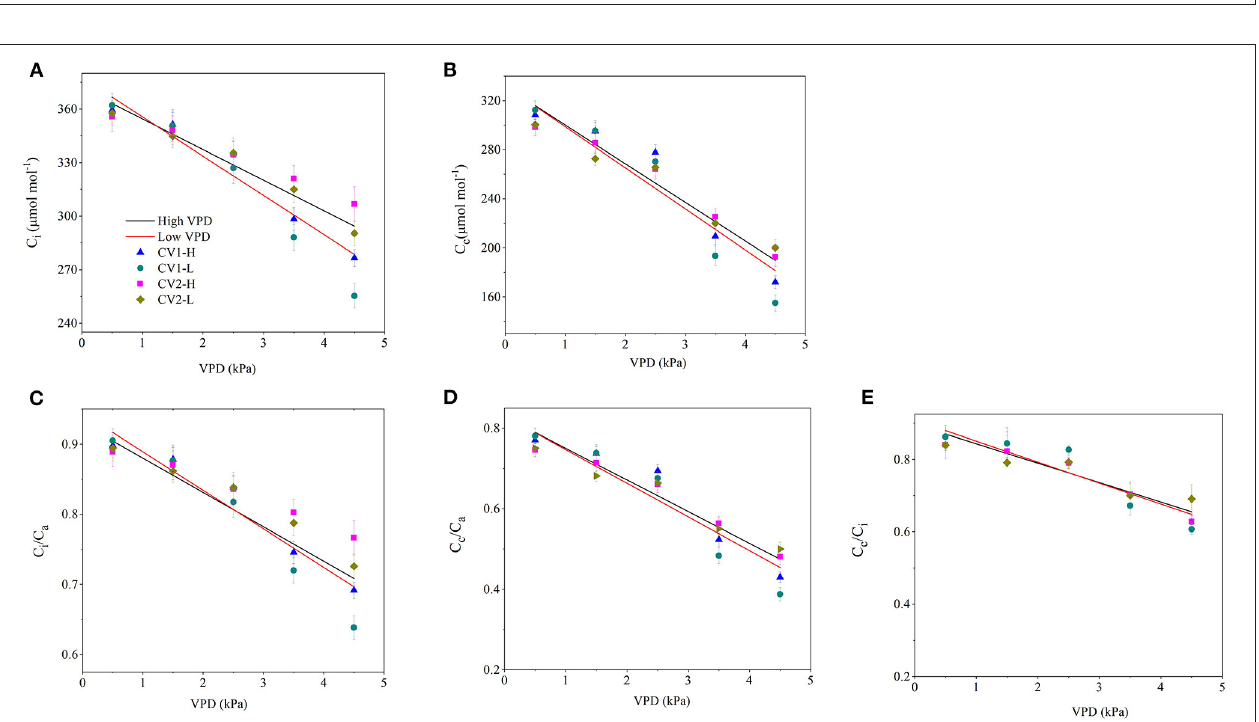
FIGURE 3 | Effect of the VPD on the intracellular CO 2 concentration [ (A) ; C i ], carboxylation sites inside chloroplasts CO 2 concentration [ (B) ; C C ], the ratio of the intercellular to ambient CO 2 concentration [ (C) ; C i /C a ], the ratio of the chloroplast to ambient CO 2 concentration [ (D) ; C c /C a ] and the ratio of the chloroplast to intercellular CO 2 concentration [ (E) ; C c /C i ]. The regression lines shown are: (A) HVPD, C i = − 17.2 VPD + 371.6, R 2 = 0.86; LVPD, C i = − 22 VPD + 377.6, R 2 = 0.87. (B) HVPD, C C = − 31.5 VPD + 331.6, R 2 = 0.91; LVPD, C C = − 33.5 VPD + 332.2, R 2 = 0.88. (C) HVPD, C i /C a = − 0.0429 VPD + 0.93, R 2 = 0.86; LVPD, C i /C a = − 0.055 VPD + 0.94, R 2 = 0.87. (D) HVPD, C c /C a = − 0.0788VPD + 0.83, R 2 = 0.92; LVPD, C c /C a = − 0.0837VPD + 0.83, R 2 = 0.87. (E) HVPD, C c /C i = − 0.0537 VPD + 0.89, R 2 = 0.82; LVPD, C c /C i = − 0.058VPD + 0.91, R 2 = 0.89.